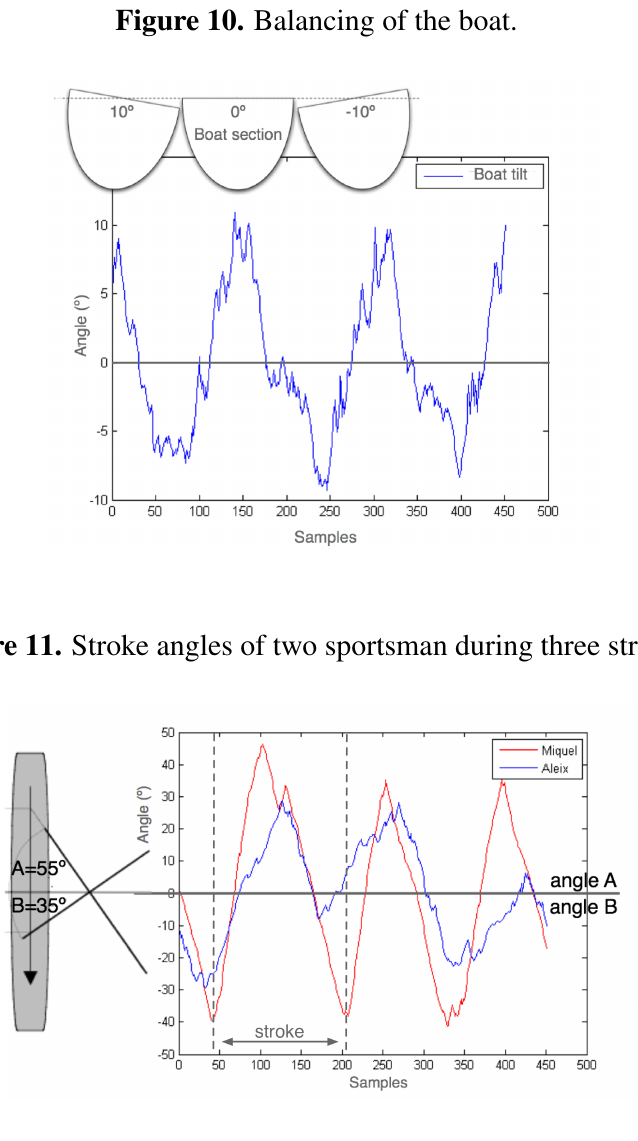
Figure 10. Balancing of the boat.